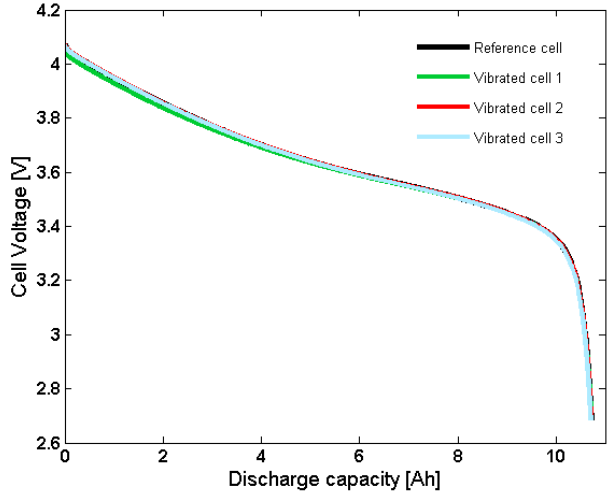
Figure 4. Capacity measurement of three vibrated cells and one reference cell.